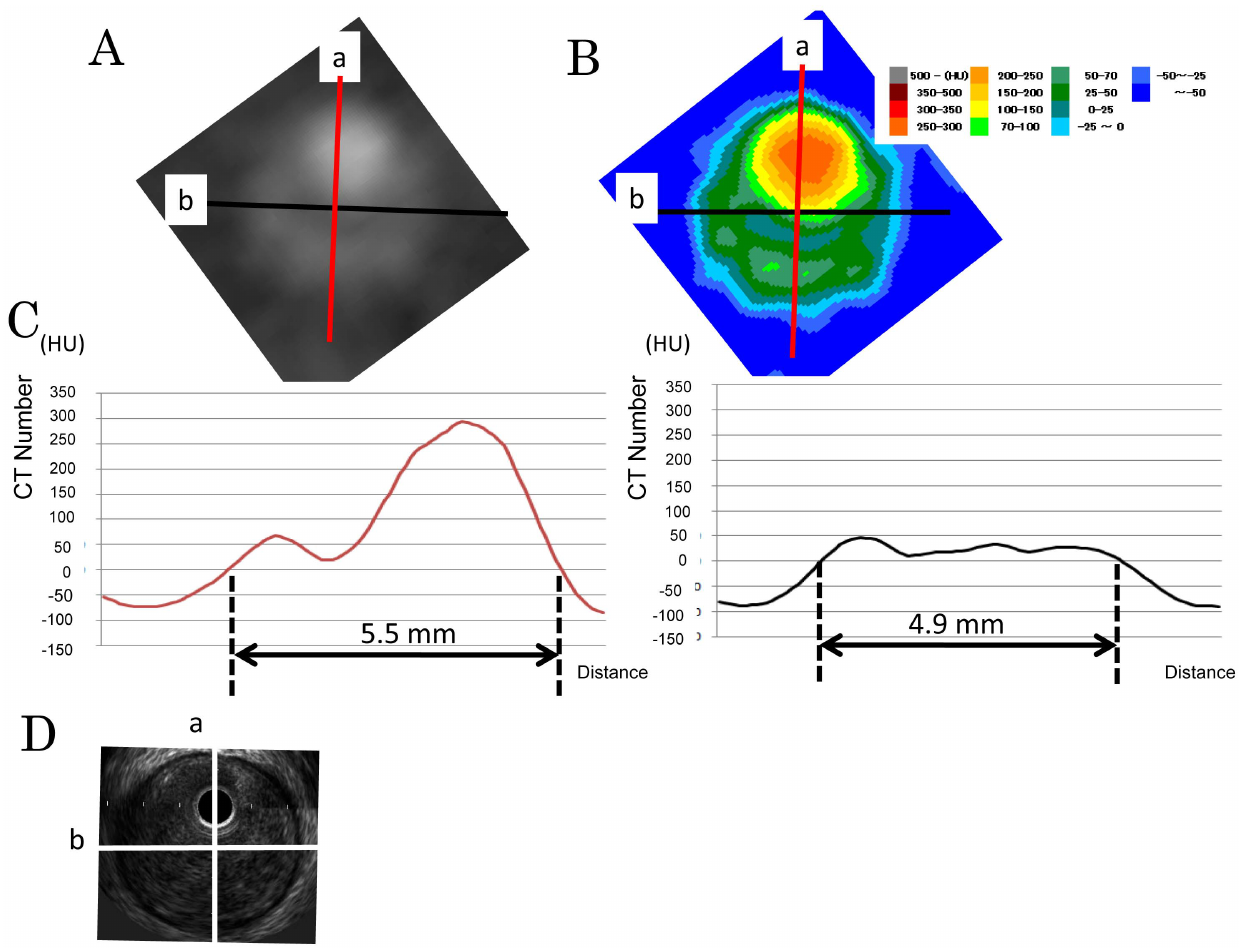
Figure 2. Quantitative analysis of grayscale image (A), Plaque Map (B), Profile curve (C) and IVUS image (D).